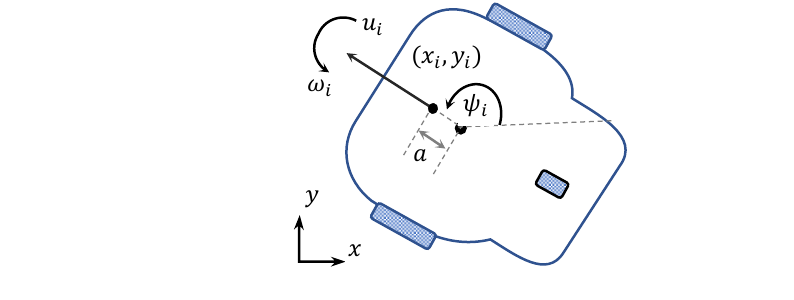
Figure 2. Differential traction mobile